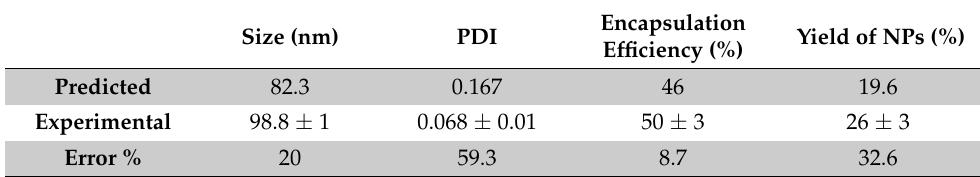
Table 9. Predicted and experimental results for